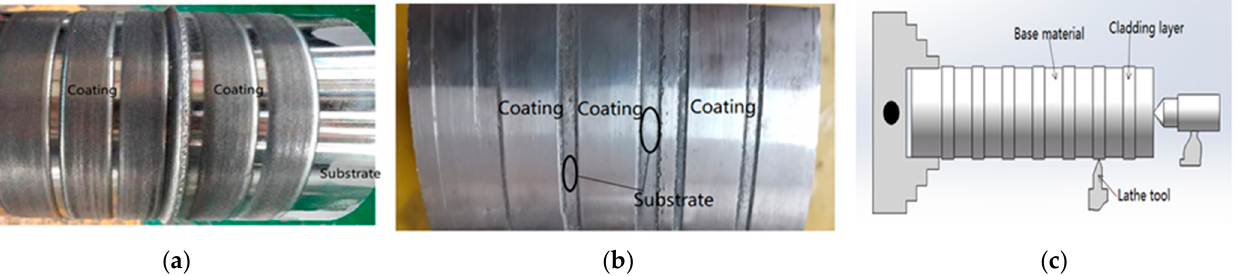
Figure 3. Molten pool morphology and turning diagrams after laser cladding and turning treatment. ( a ) Melt pool morphology; ( b ) shape after turning; ( c ) schematic diagram of turning to processing.